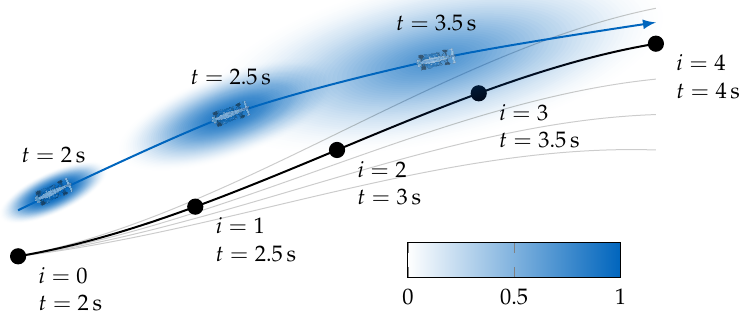
Figure 4. Prediction cost. The considered edge, shown in black, is discretized with five points and covers the time range from t = 2s to t = 4s. The predicted path is shown in blue, together with the ellipses for the discretization points i = 0,1,3. The point i = 3 is covered by the corresponding ellipses so that the prediction cost of this edge is